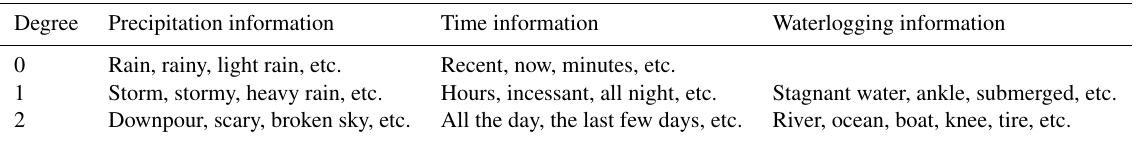
Table 2. The intensity dictionary for assessing waterlogging risk. Degree Precipitation information Time information Waterlogging information Rain, rainy, light rain, etc. Recent, now, minutes, etc. Storm, stormy, heavy rain, etc.